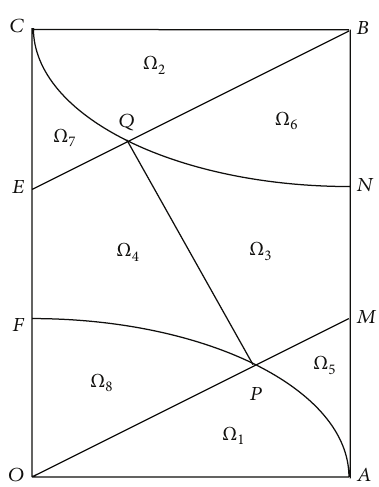
Figure 1: Domains Ω 𝑖 (𝑖 = 1,2,...,8) , characteristics: OPM : 𝑥 =